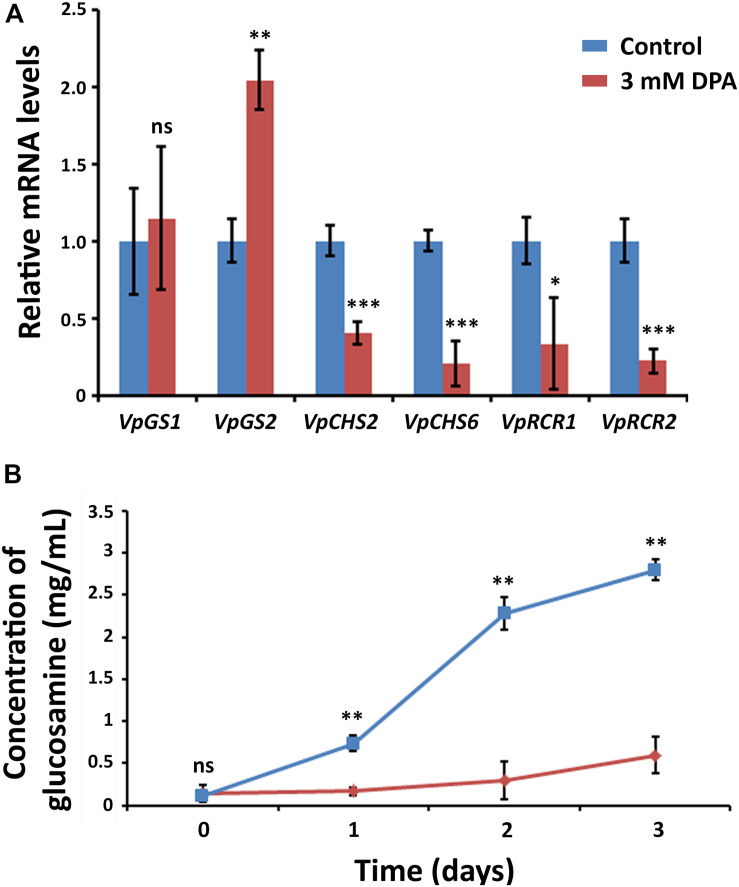
Metabolic effects of DPA. (A) Measurement of the mRNA levels in DPA-treated V. pyri conidia. Glucan biosynthesis genes VpGS1 and VpGS2 and chitin biosynthesis genes VpCHS2, VpCHS6, VpRCR1, and VpRCR2 were examined. V. pyri was treated with 3 mM DPA (pH = 5), whereas the control experiments were performed in the absence of DPA. The obtained results indicated that DPA is inhibiting the biosynthesis of chitin. (B) Determination of chitin concentration in V. pyri after treatment with 3 mM DPA at pH = 5. The control experiment was carried out in the absence of DPA. The concentration of chitin was lower in the DPA-treated fungi in comparison to that in the non-treated fungi, demonstrating that DPA is inhibiting the biosynthesis of chitin. Significance levels at *P < 0.05, **P < 0.01, ***P < 0.001, and no significance (ns).